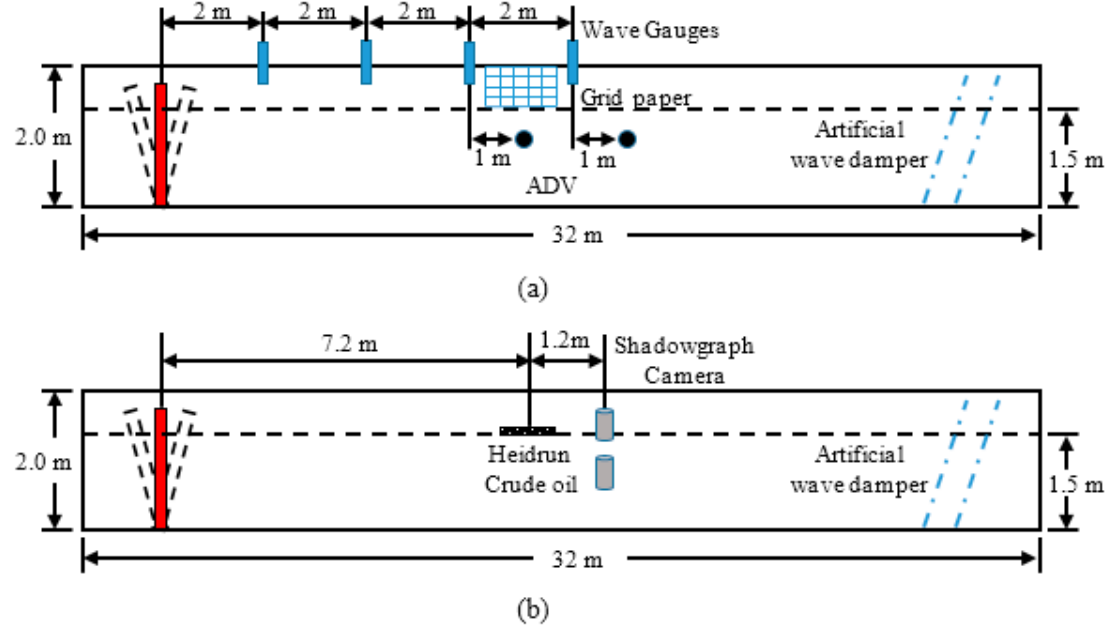
Figure 2. Schematic illustration of the ( a ) breaking wave experiment and ( b ) oil dispersion